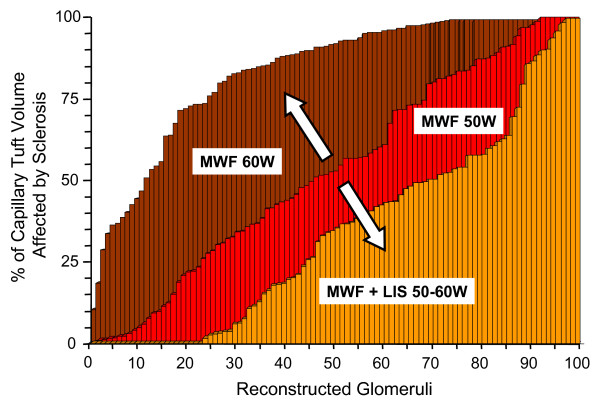
Regression of glomerulosclerosis by ACE inhibition in an experimental model for progressive kidney disease. Distribution of nonsclerosed capillary tissue as estimated by serial section reconstruction of the entire capillary tuft in Munich Wistar-Frömter rats at 50 weeks of age (in red), in untreated rats at 60 weeks of age, (in brown) and in animals treated with the ACE inhibitor lisinopril from 50-60 weeks of age (in yellow). In total, 100 glomeruli have been completely reconstructed in each animal group. Numbers in the abscissa represent reconstructed glomerular capillary tufts.